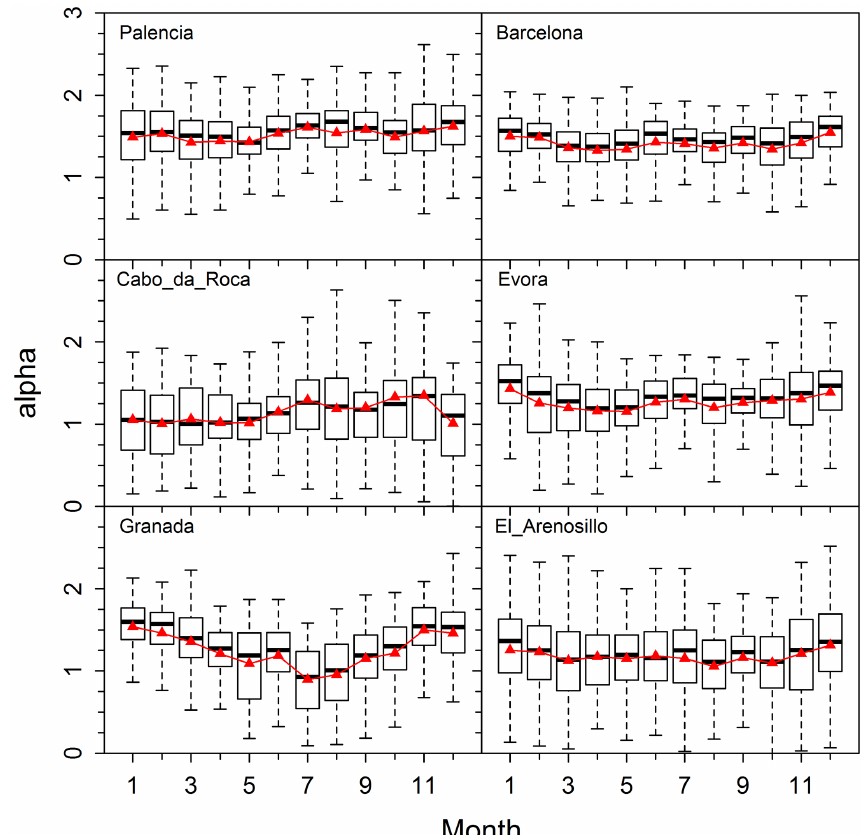
Figure 2. Annual cycle of daily values of α (“alpha” in the figure) in box whisker plots for the six sites studied. Triangles and horizontal solid lines indicate the monthly average and median values,